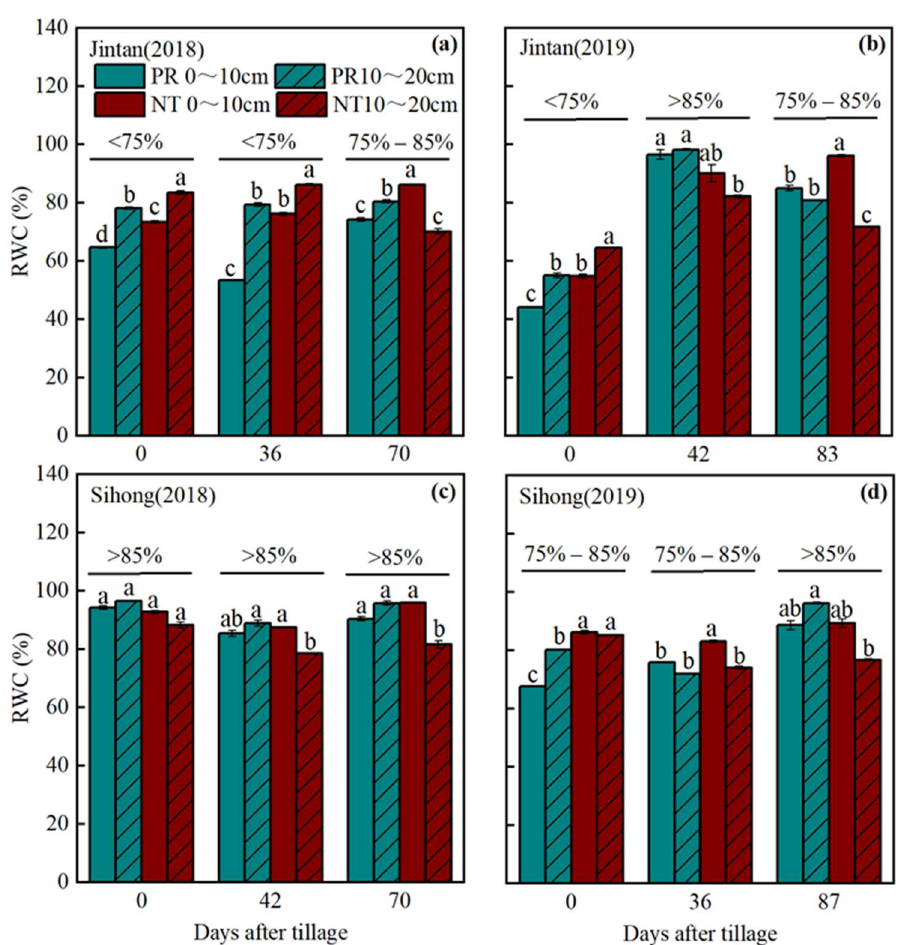
Figure 4. Effects of tillage methods on relative water content (RWC) in 0–10 cm and 10–20 cm soil at different days after tillage (DAT) at the experimental sites of Jintan ( a , b ) and Sihong ( c , d ) in 2017–2018 ( a , c ) and 2018–2019 ( b , d ). Tillage methods included plow tillage followed by rotary tillage (PR) and no-tillage (NT). All values are presented as mean ± SE (3 replicates) with one standard error. For the same time after tillage, bars labeled with different letters indicate significant differences among different tillage methods and soil layers at the p < 0.05 level. The value above each set of bars is the range of the average RWC of different treatments and soil layers.